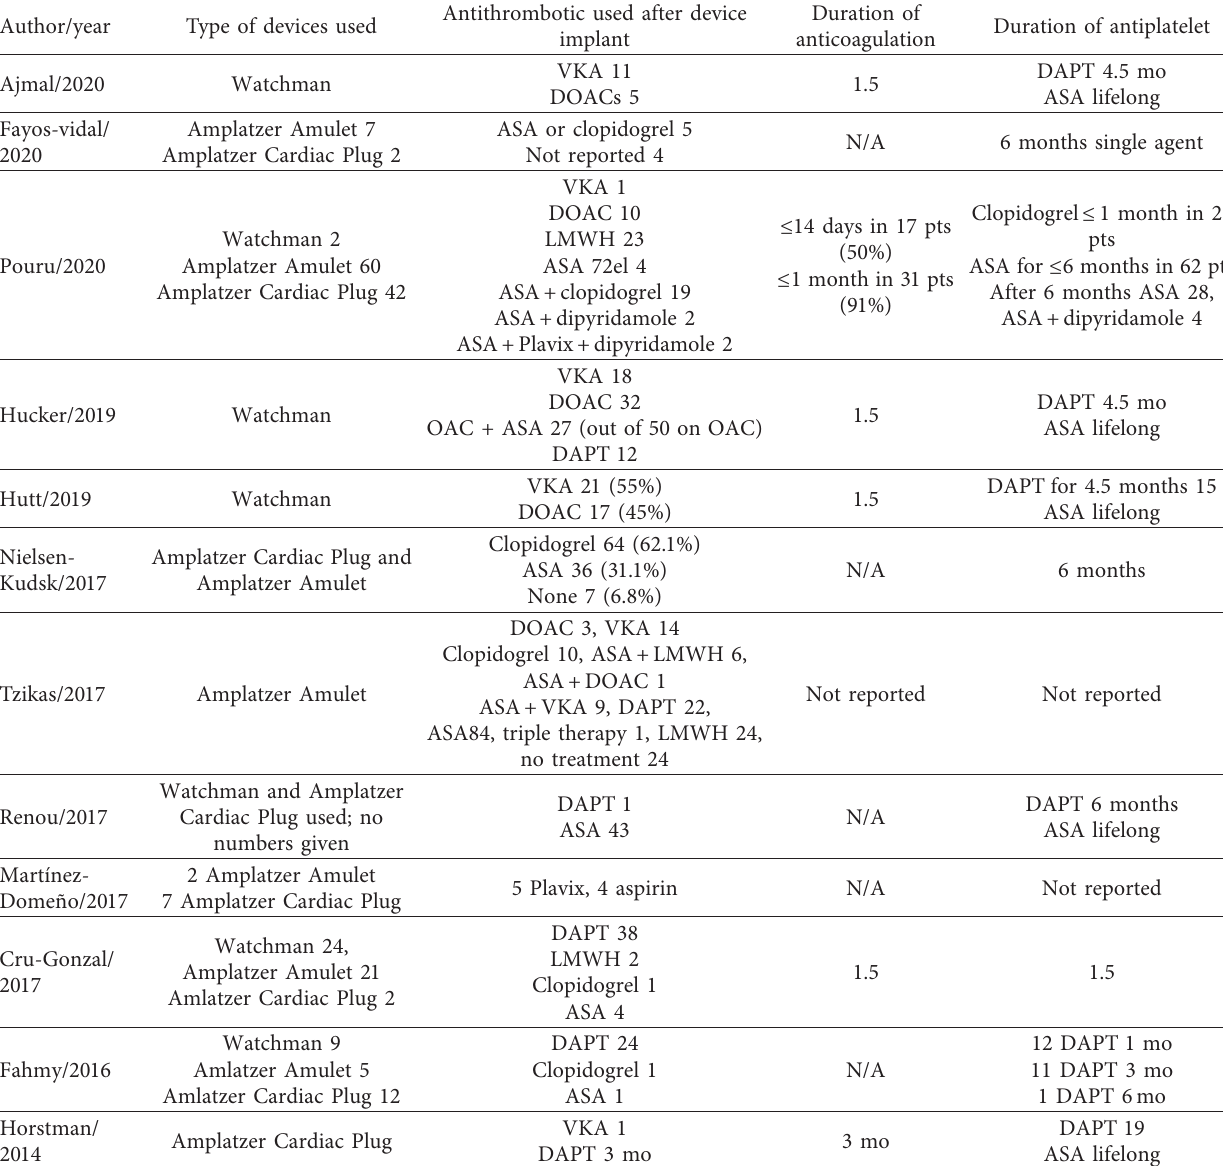
Table 3: Type of devices and antithrombotic regimen after device